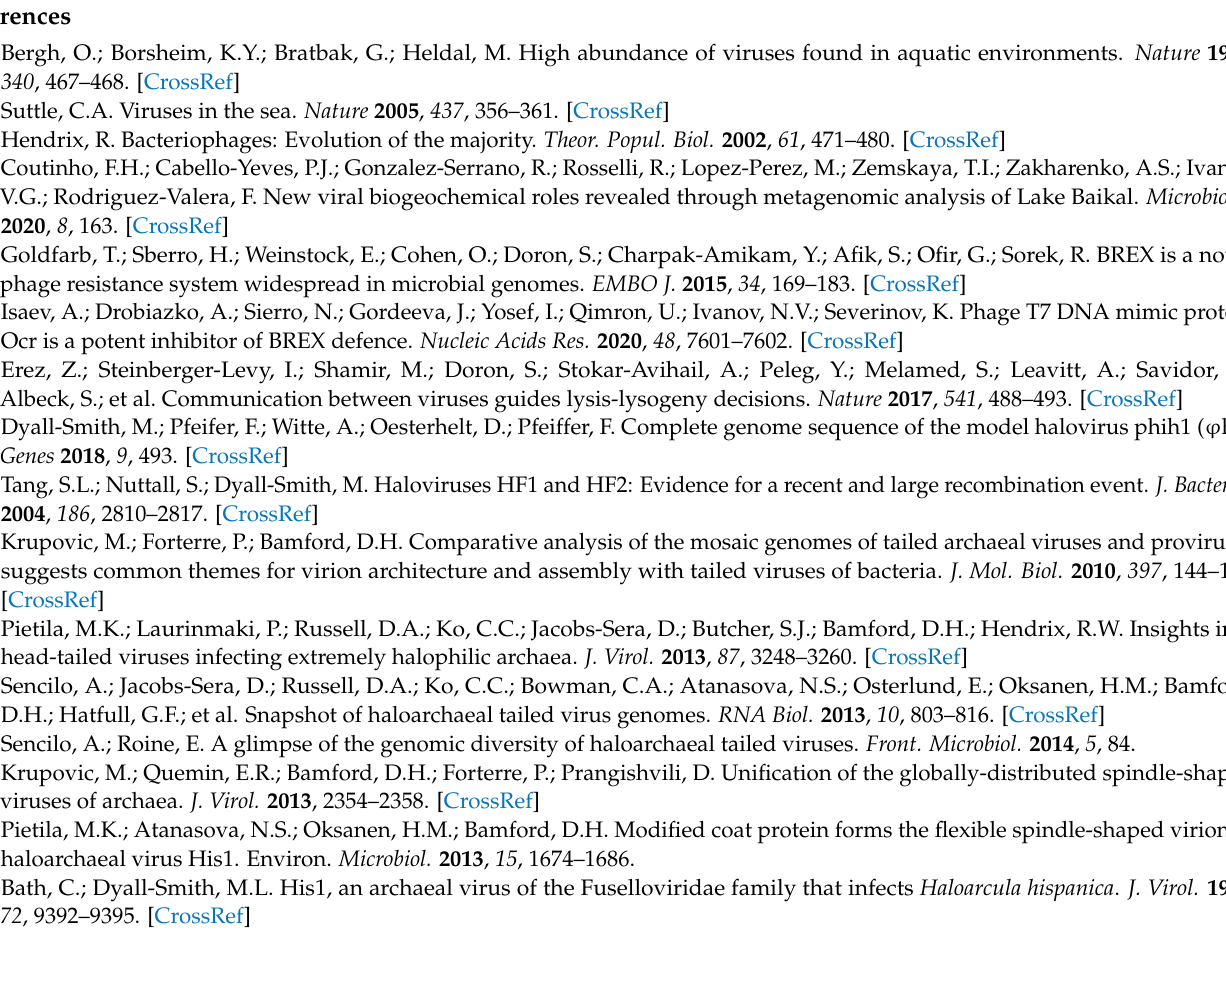
Supplementary Figure S5: Screenshot of Geneious window showing Hfx. volcanii Hv1 reads (SRX8436462) mapped to the termini of circularised Halfvol1. Supplementary Figure S6: Screenshot of Geneious window showing Hfx. volcanii Hv1 reads (SRX8436462) mapped to Hfx. volcanii DS2, showing the region around the left end of provirus Halfvol1 in the main